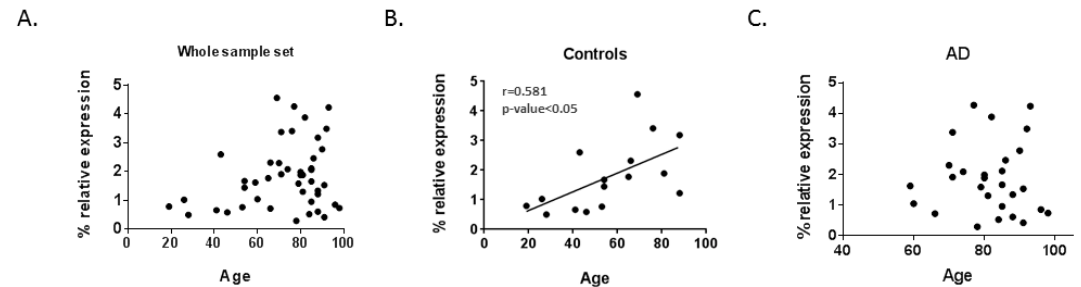
Figure 3. Scatter-plots showing the correlation level between LMNA mRNA levels and age. ( A ) No association was found between age and LMNA mRNA expression within the whole sample set (controls and Alzheimer’s patients). ( B ) Control group presented a medium significant positive correlation between LMNA mRNA levels and age. ( C ) No correlation within the AD group was observed between LMNA mRNA and age. Dots represent each sample according to percentage of LMNA expression relative to the geometric mean of GAPDH and ACTB housekeeping genes expression and their age. The straight line shows the regression line of LMNA mRNA levels and age. AD = Alzheimer’s